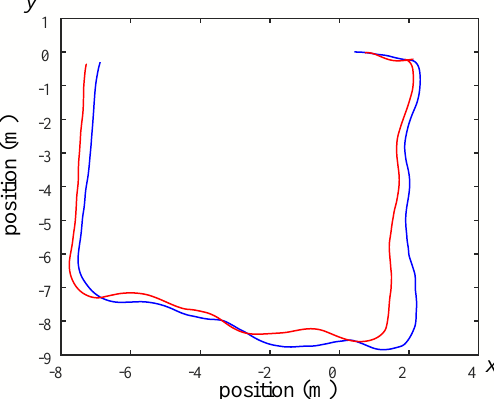
Figure 26. The odometry of using Gmapping (Red path is real path and blue path is predicted path).